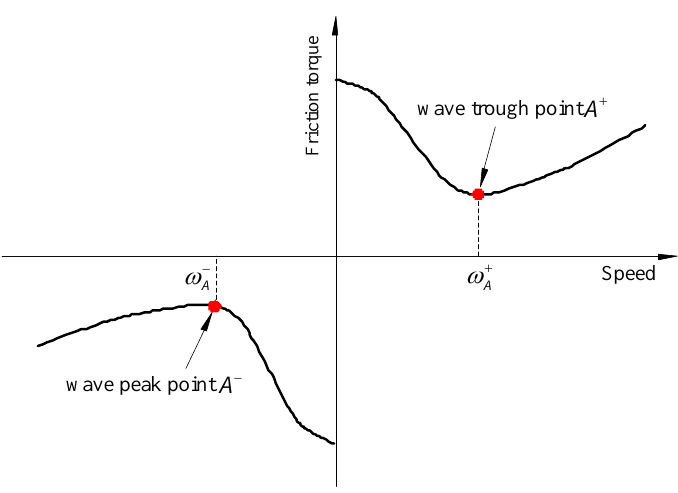
Figure 2. Optimal measurement speed.